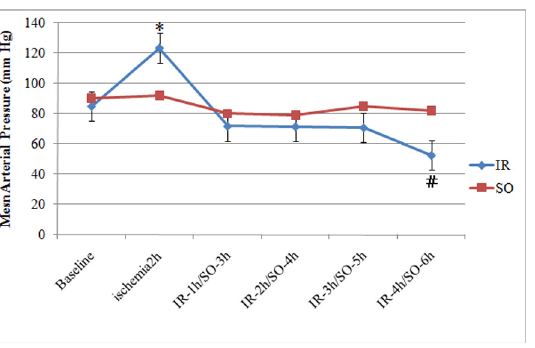
Fig 2. Mean arterial pressure measurements in IR animals and corresponding SO animals. * p < 0.001 vs. baseline, IR and SO groups.#p < 0.001 vs. baseline, and corresponding SO